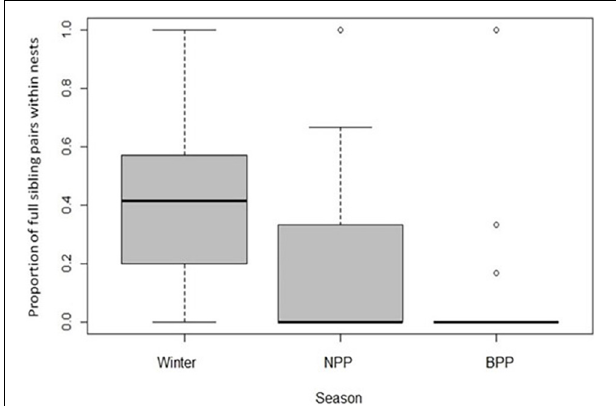
FIGURE 2 | Decline in kinship among social nestmates prior to the formation of breeding associations. Winter associations represent natal nestmates, since bees overwinter in their natal nests. The proportion of nest mate pairs that were full sisters decreased significantly from winter, through the spring nestmate provisioning phase (NPP) to the summer brood provisioning phase (BPP) (Kruskal-Wallis X 2 = 13.01, d.f. = 2, P = 0.001). Boxes-and-whiskers represent median and quartile ranges, while open circles represent